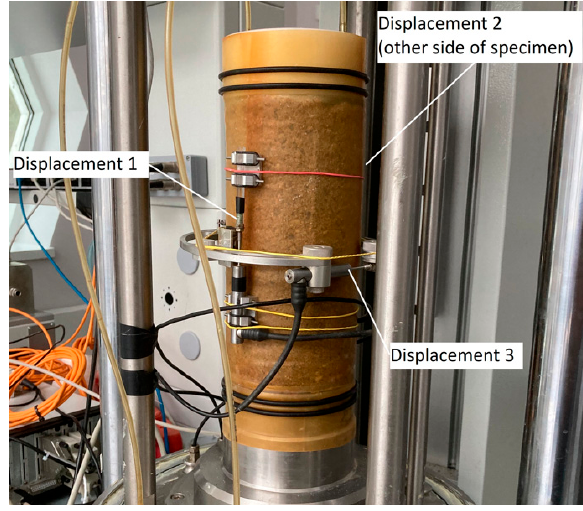
Figure 2. Specimen with attached mounted LVDTs before the start of cyclic triaxial test.